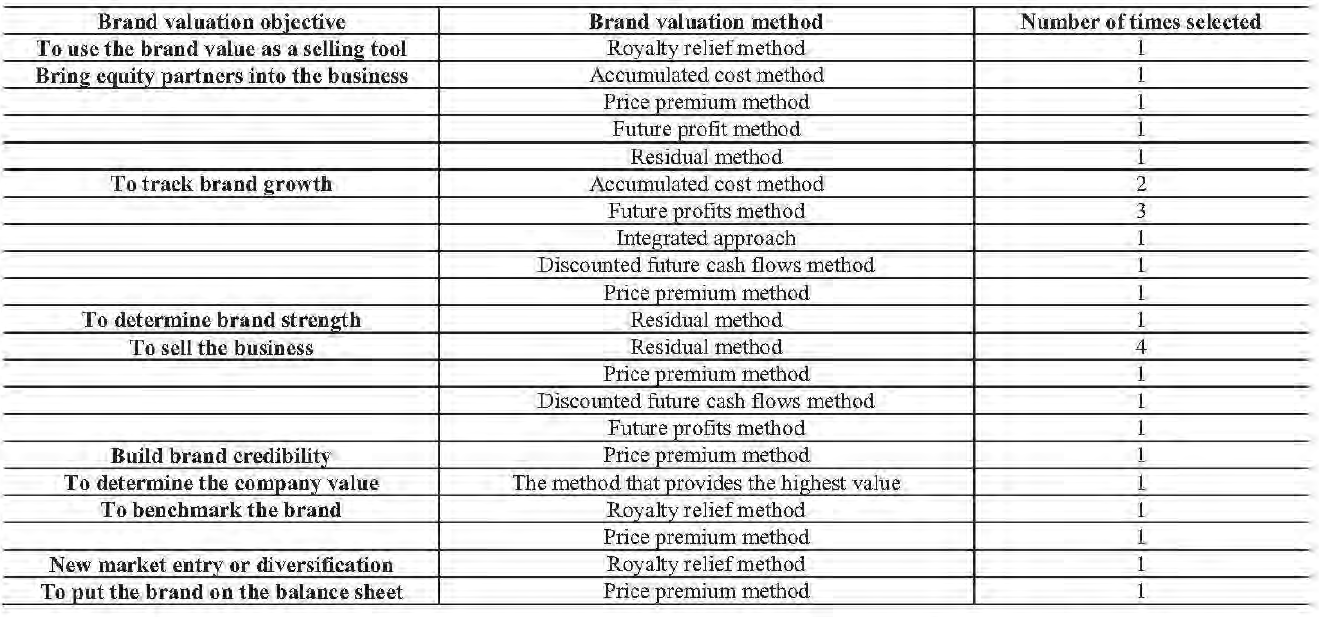
Table 3: Brand valuation method selected for different brand valuation objectives Brand valuation